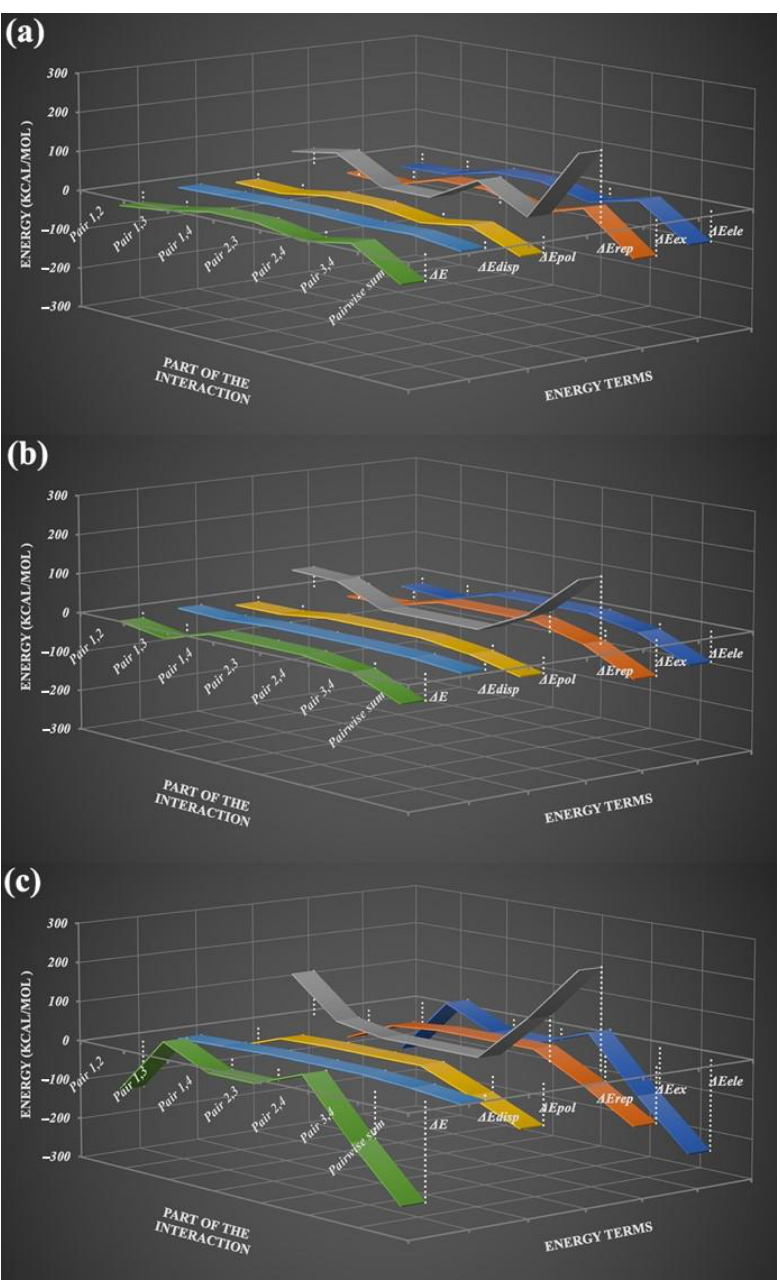
Figure 8. GSK-EDA of the cocrystals and salt of TNX, ( a ) TNX-DNB, ( b ) TNX-PAS, and ( c ) TNX-DHB.